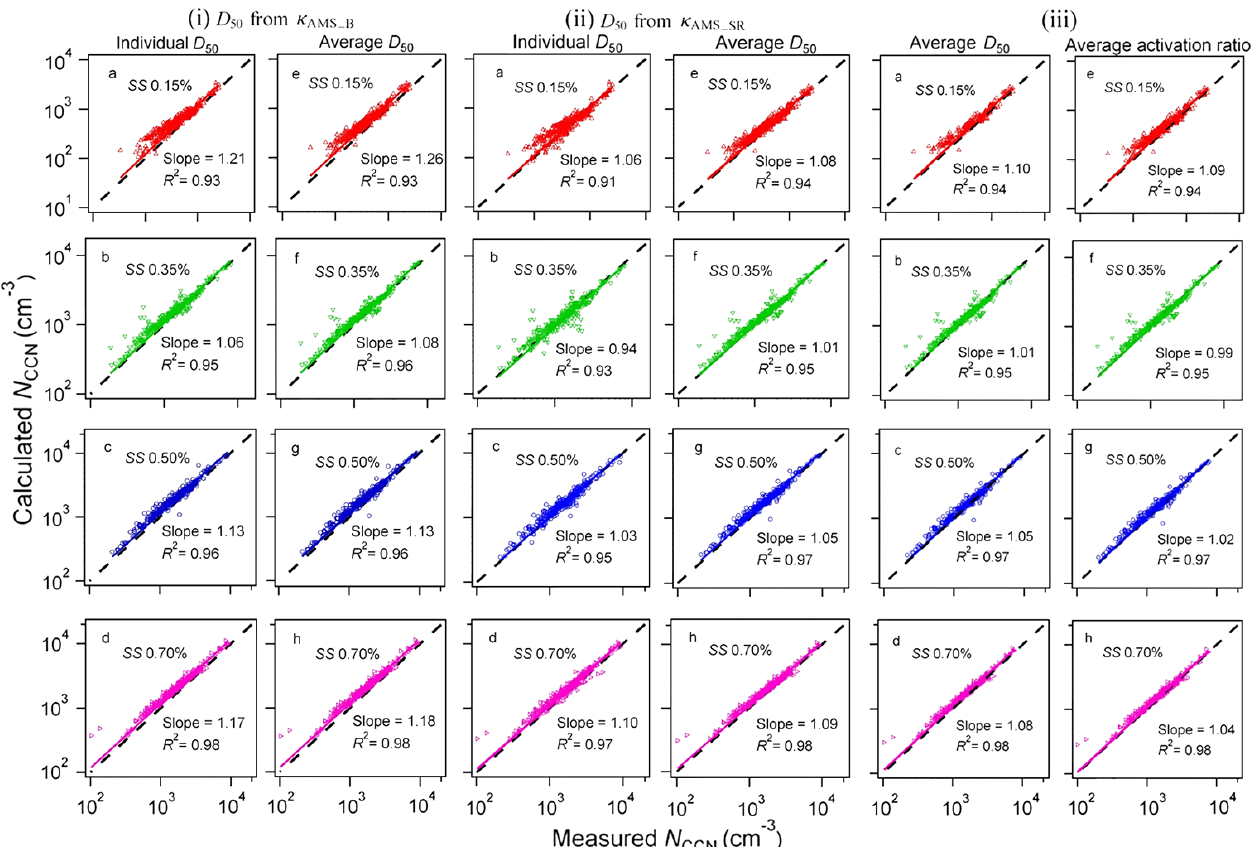
Figure 5. Calculations of N CCN based on (i) (a–d) the individual D 50 and (e–h) the average D 50 over the whole period from κ AMS_B , (ii) (a–d) the individual D 50 and (e–h) the average D 50 over the whole period from κ AMS_SR and (iii) (a–d) the average D 50 and (e–h) the average size-resolved CCN activation ratio from CCN measurement over the whole